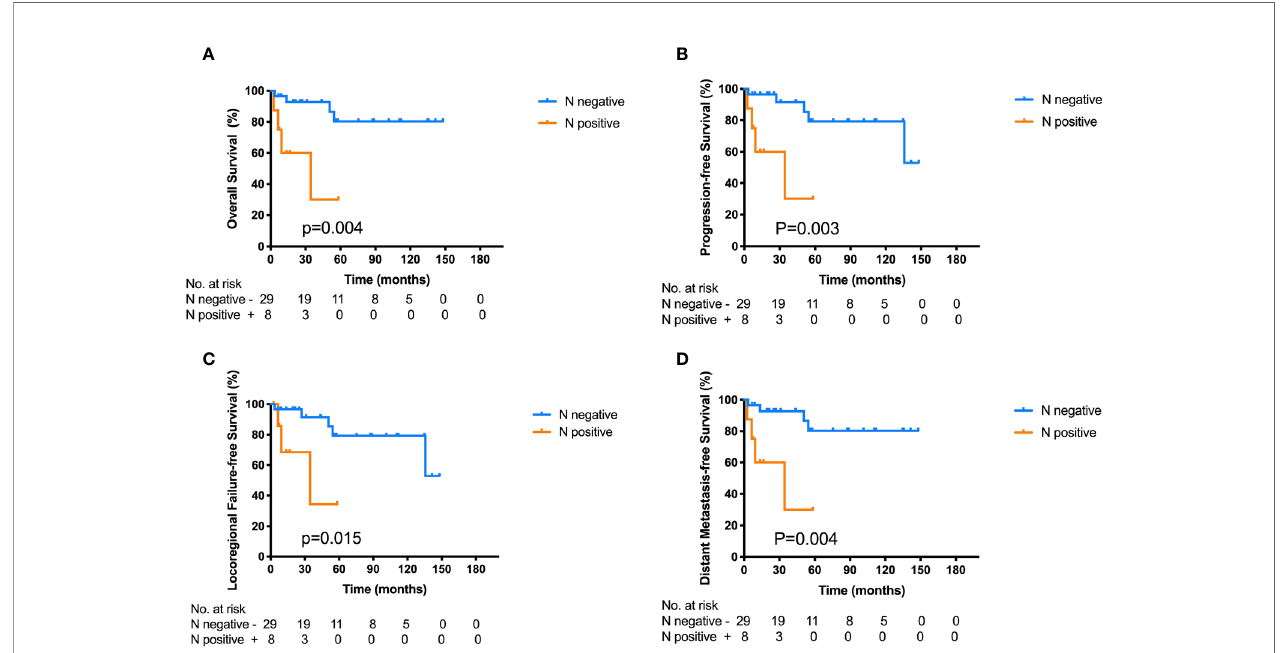
FIGURE 3 | Kaplan – Meier survival curves for overall survival (OS) (A) , progression-free survival (PFS) (B) , locoregional failure-free survival (LRFS) (C) and distant metastasis-free survival (DMFS) (D) of the 37 ONB patients with frontal lobe invasion according to the cervical lymph node metastasis at initial diagnosis. Log-rank tests show that ONB patients without lymph node metastasis have superior 3-year OS (p = 0.004), PFS (p = 0.003), LRFS (p = 0.015), and DMFS (p = 0.004) compared with those having cervical lymph node metastasis.